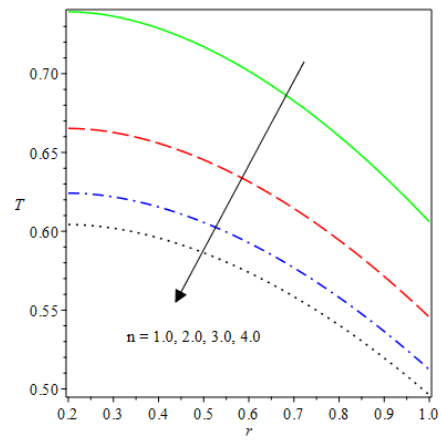
Figure 12. Temperature profile for rising ( m ) .